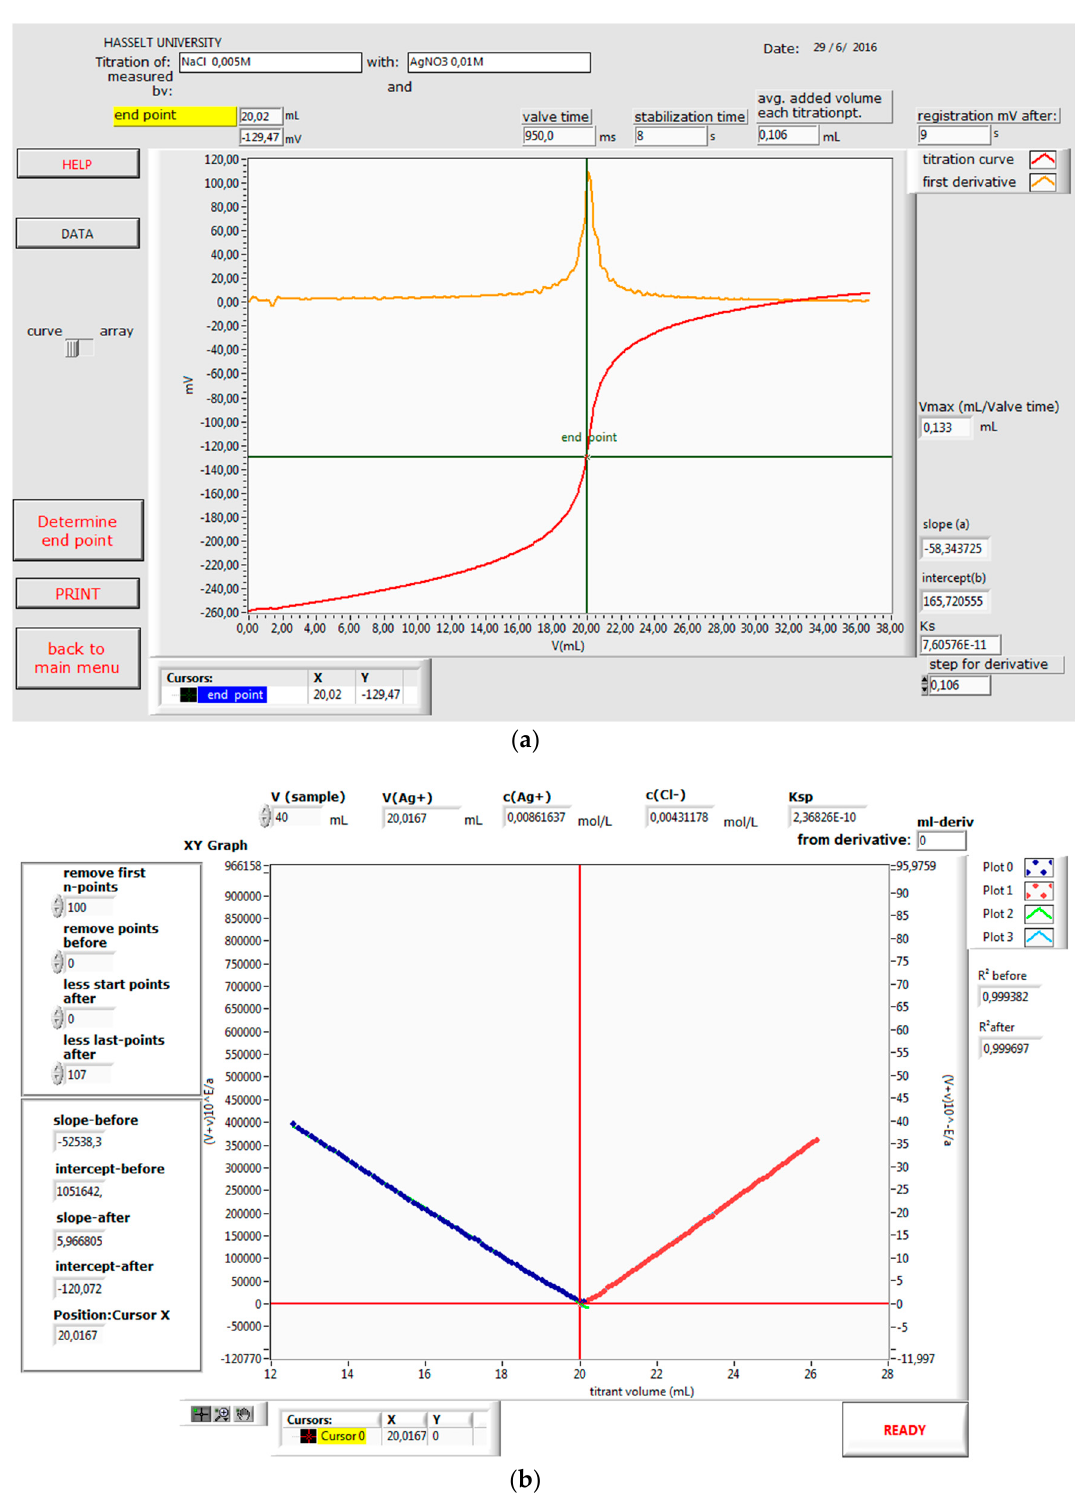
Figure 5. ( a ) Precipitation titration curve (titration 2; Table 1) of an unknown NaCl solution at 297.81 K (temperature at the end point), E (mV) versus V (mL) AgNO 3 standard solution (red); plot of numerical first derivatives (built-in LabVIEW VI function) with a maximum at the endpoint (orange); ( b ) Gran plot with an intersection of two linear regression lines at the end point of the titration.